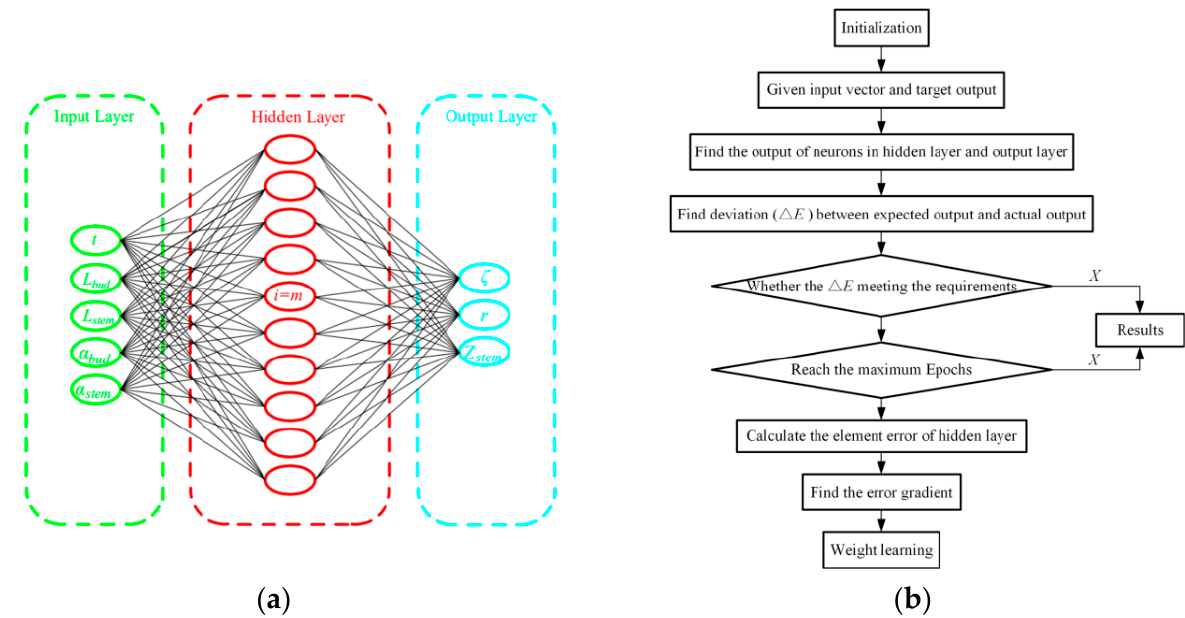
Figure 6. Established ANN ( a ) and the corresponding training process ( b ) .